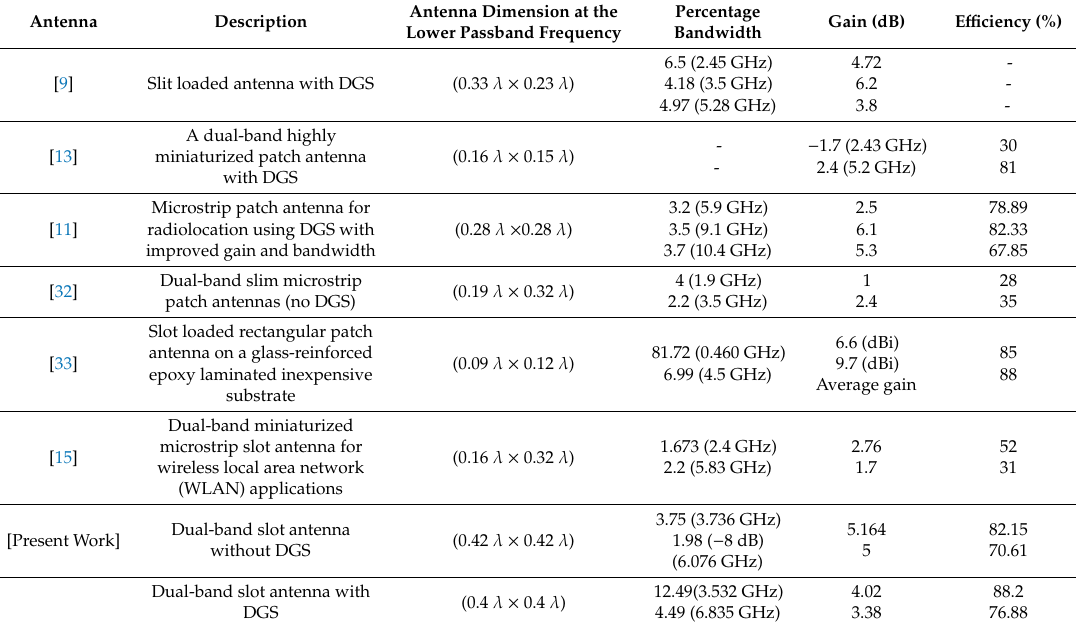
Table 2. The comparison between the results of some previous work with the present one (here λ represents the wavelength of the corresponding lower resonant